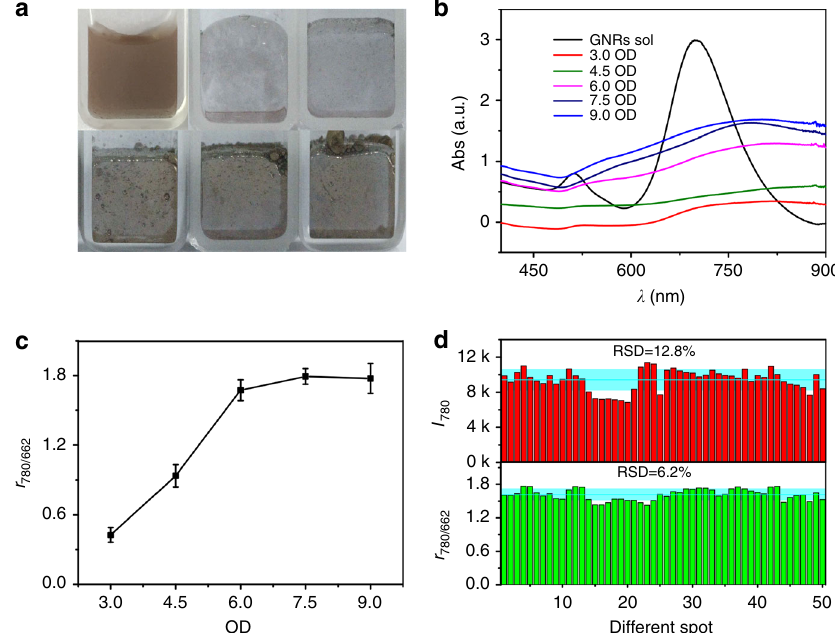
Fig. 7 Effect of GNR concentrations on SERS performance. a Optical images of as-synthesized GNR sols and metal liquid-like GNR arrays on O- in -W interface fabricated by 1 mL of GNR sols with variable OD values: 3.0, 4.5, 6.0, 7.5, and 9.0, respectively. b The corresponding UV – Vis absorbance spectra, c relative SERS strength, r 780/662 , collected on interfacial GNR arrays, and d statistical histograms of r 780/662 and I 780 , respectively. The error bars represent the statistical RSD and were calculated from triplicate SERS